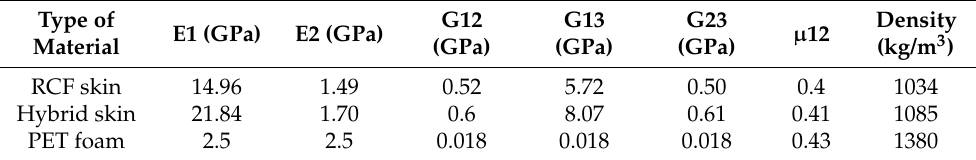
Table 1. Materials properties used for Finite Element Analysis